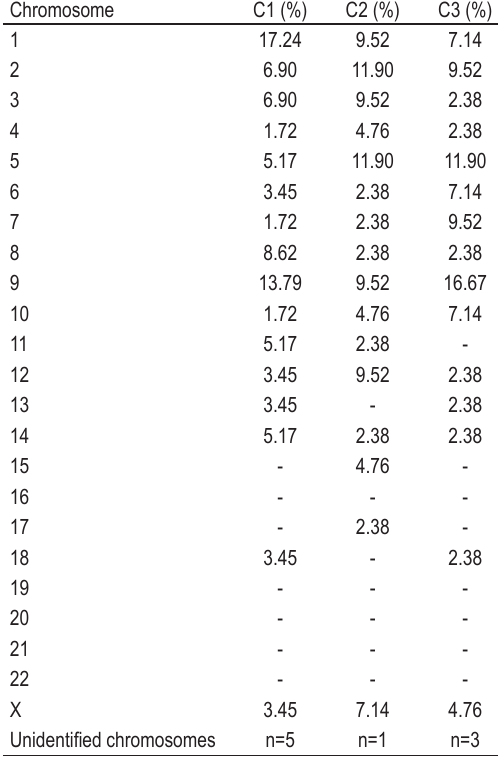
TABLE 3. Frequency of individual chromosome aberrations